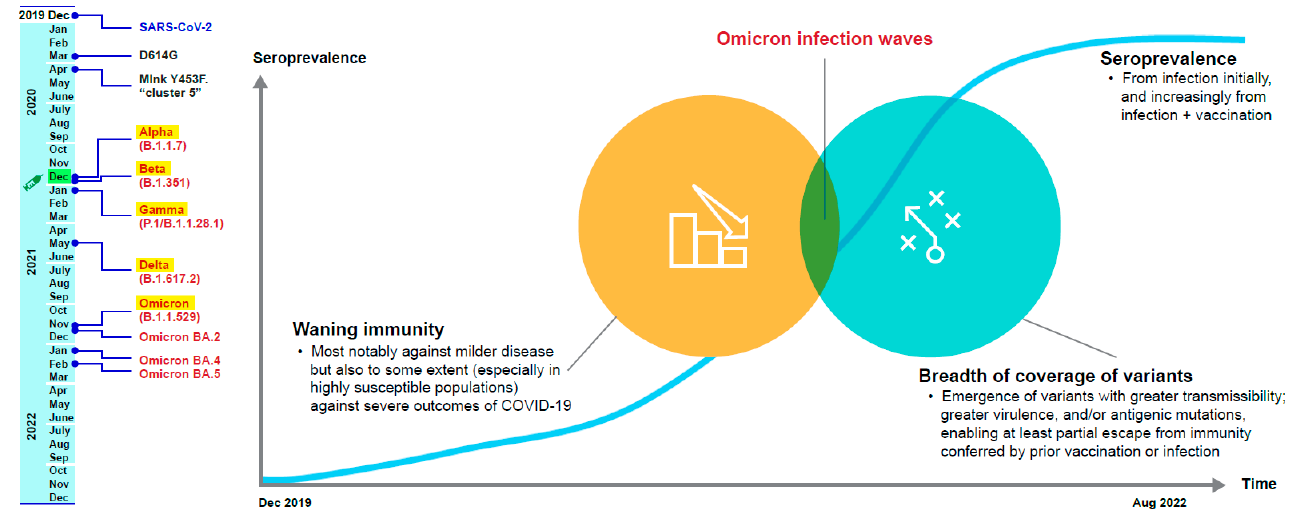
Figure 1. The challenges of maintaining protection against SARS-CoV-2 [10–18] .